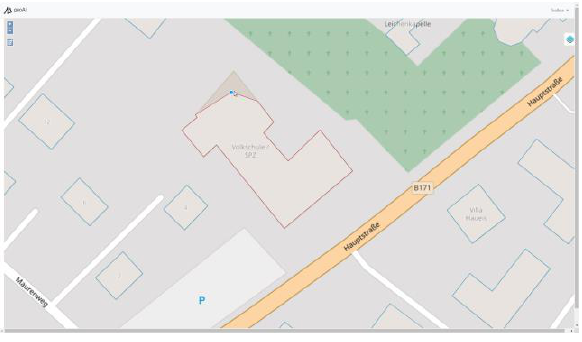
Figure 6. Vector editing functionality on the WebGIS interface.